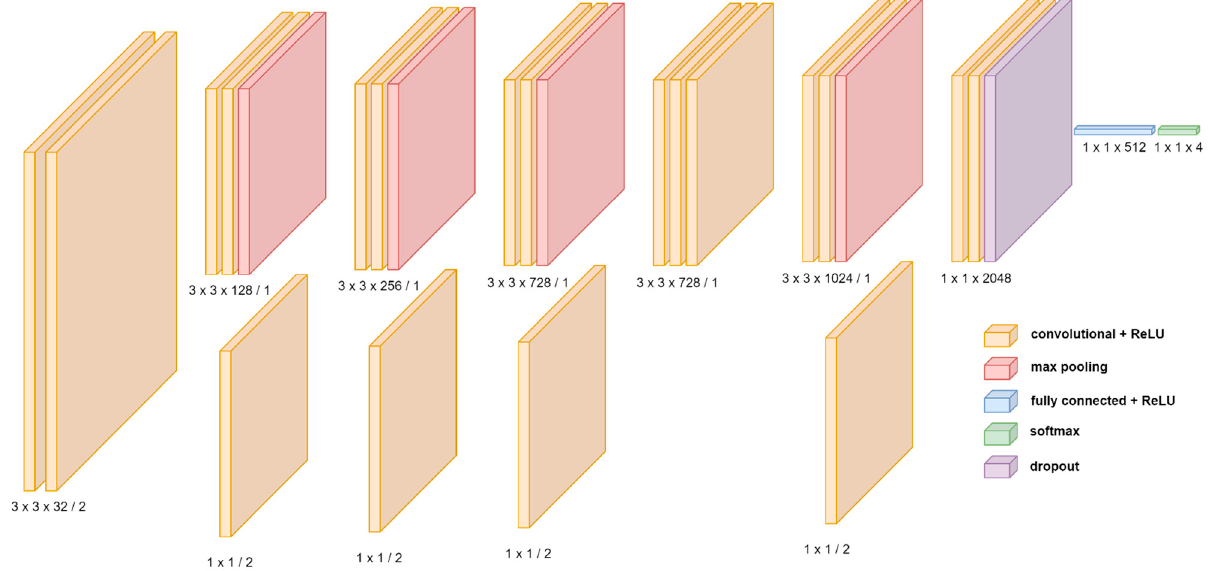
Figure A2. Visualization of the Xception model architecture.